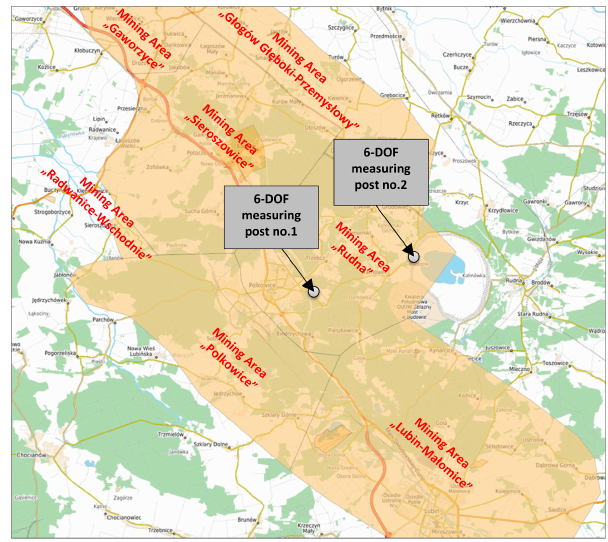
Figure 3. Location of six-degrees-of-freedom (6-DOF) measuring posts in the LSCB area.